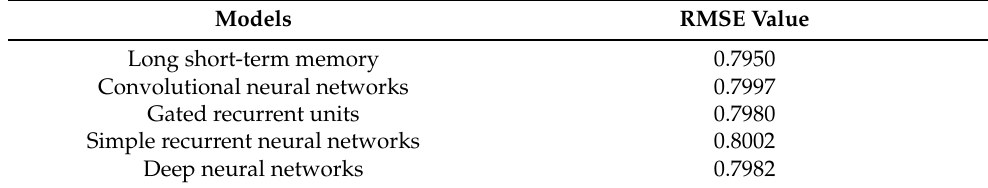
Figure 4. The prediction error measurement of mainstream deep learning models on training and test sets. Table 1. The prediction error measurement of the mainstream deep learning models in terms of root-mean-square error